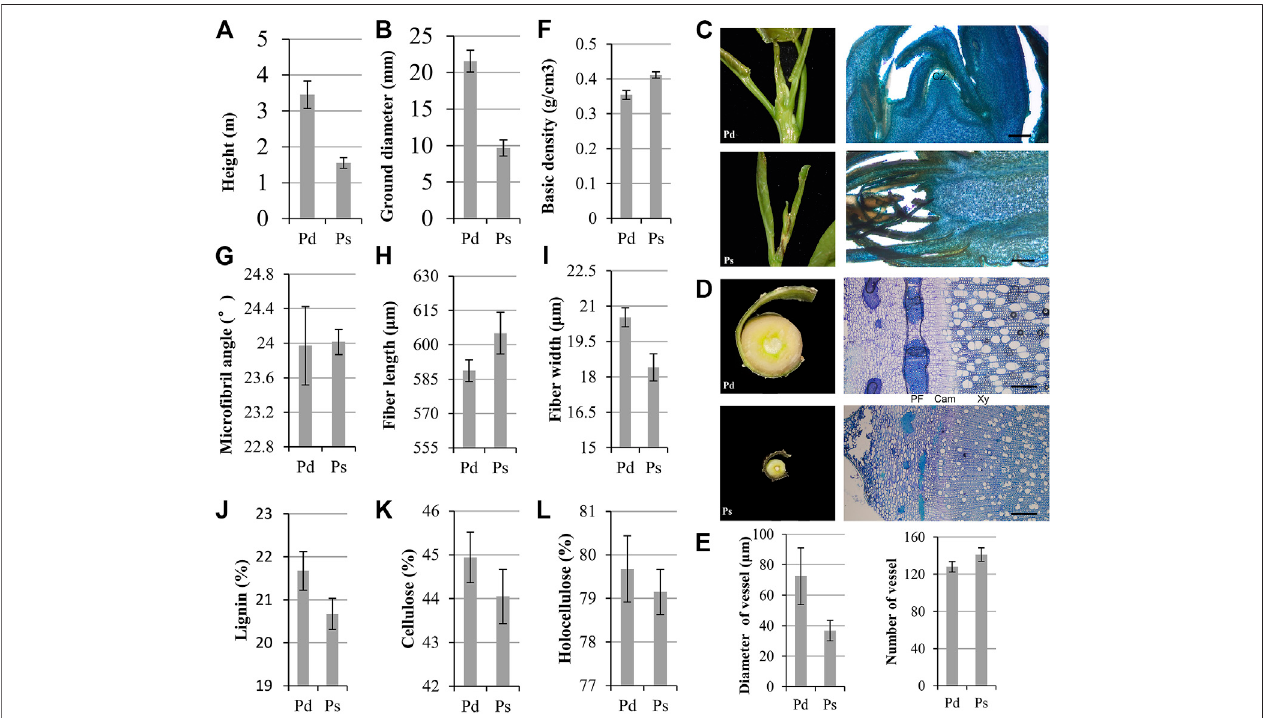
FIGURE 1 | Phenotypic traits of P . deltoides “ Danhong ” (Pd) and P . simonii “ Tongliao1 ” (Ps). Annual plant height (A) and ground diameter (B) of Pd and Ps. (C) Shoot apical meristem (SAM) image and section of Pd and Ps. Scale bars (cid:2) 500 μ m. (D) Cross sections of phloem – xylem region from 1-year-old trees. Scale bars (cid:2) 200 μ m. (E) VesselsizeandnumberofvesselinthesameareaofPdandPs.CZ,centralzone;PF,phloem fi ber;Cam,cambium;Xy,xylem.Basicdensity (F) ,micro fi bril angle (G) , fi ber length (H) , fi ber width (I) , lignin (J) , cellulose (K) , and holocellulose (L) content of Pd and Ps. Mean ± SD from three biological